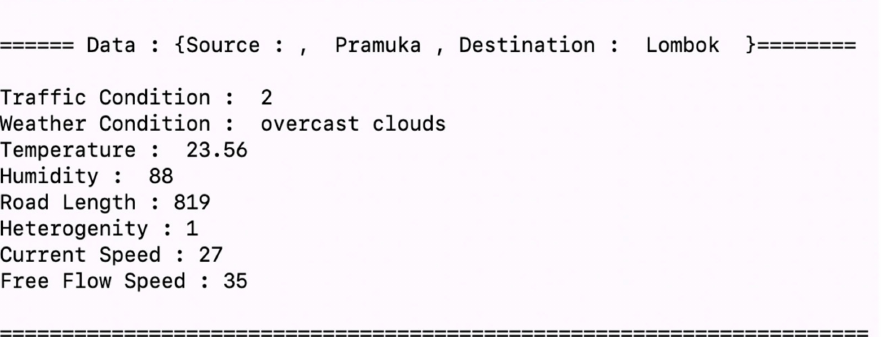
Figure 20. Road information collection.